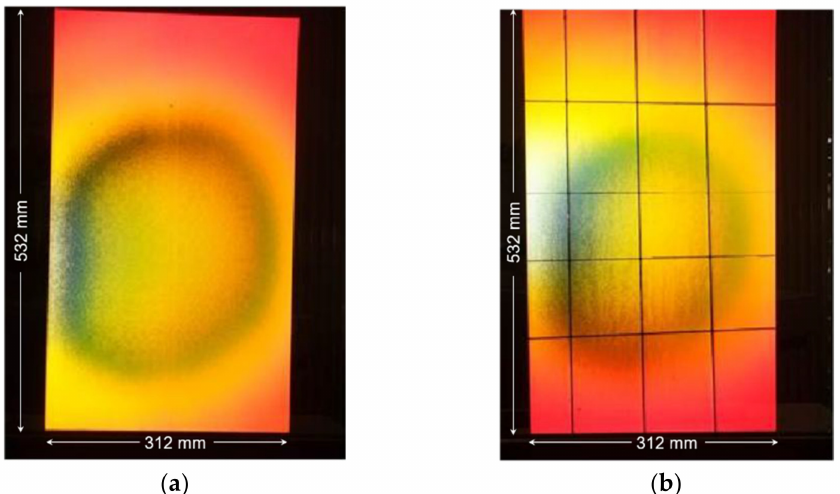
Figure 7. View into the P-HOE from the position of the focal position of the real image of the diffusor (phase-conjugated reconstruction). ( a ) A P-HOE in which the photopolymer was laminated on top of a 10 mm thick glass plate. ( b ) The result of a repeated recording. In this case the photopolymer was crosscut into small rectangles before recording and was still laminated onto the glass